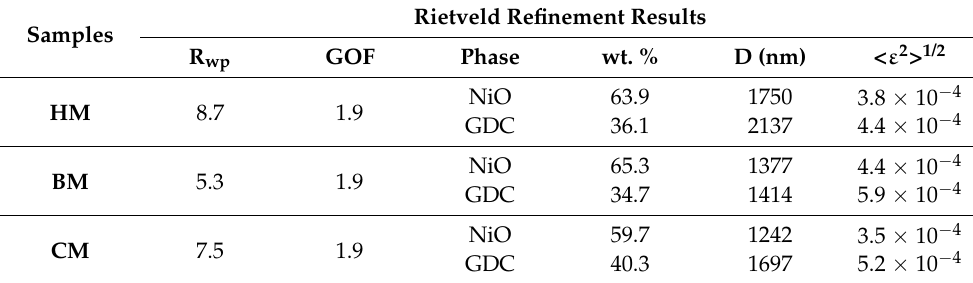
Figure 6. XRD patterns of the NiO-GDC sintered discs obtained by CM, BM, and HM methods (d represents the sintered disc). Table 3. Quantitative analysis of phases of the sintered discs analyzed from the Rietveld and the quality refinement parameters. GOF: goodness of fit; D: mean crystallite size; < ε 2 > 1/2 : root mean square (rms) of the microstrain.